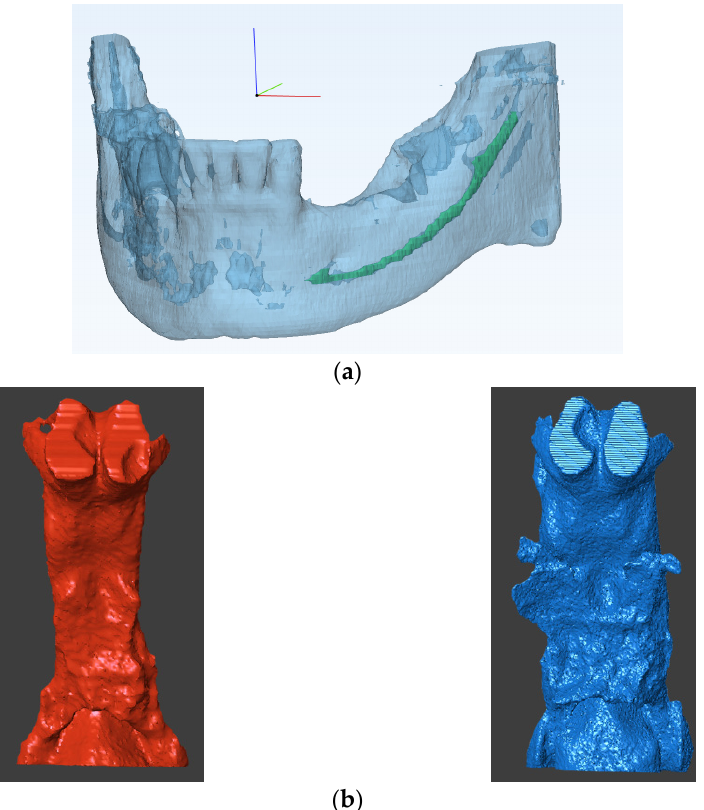
Figure 4. ( a ) Visualization of nerve location in the mandible for tool design. ( b ) 3D printing of upper airway before (red) and after treatment (blue).